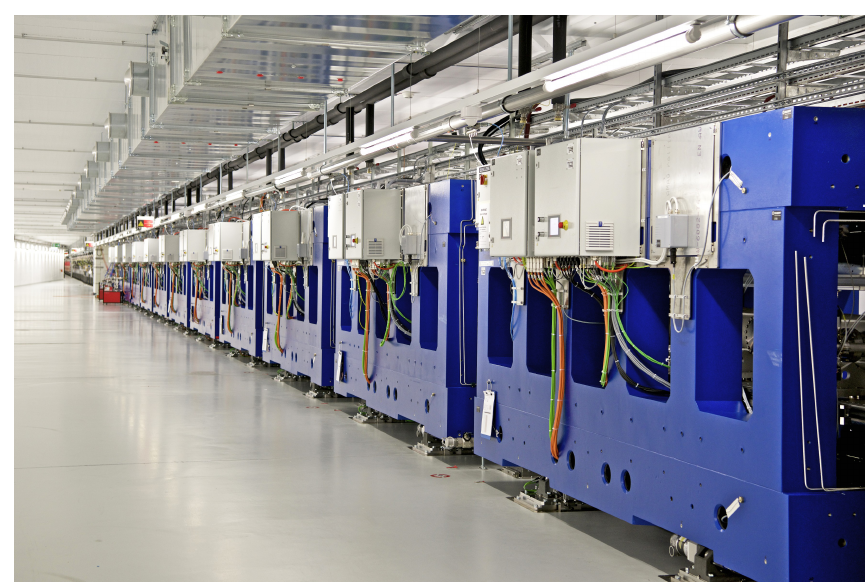
Figure 3. SwissFEL Aramis undulator line with a total length of 60m (4m each module and 0.75m